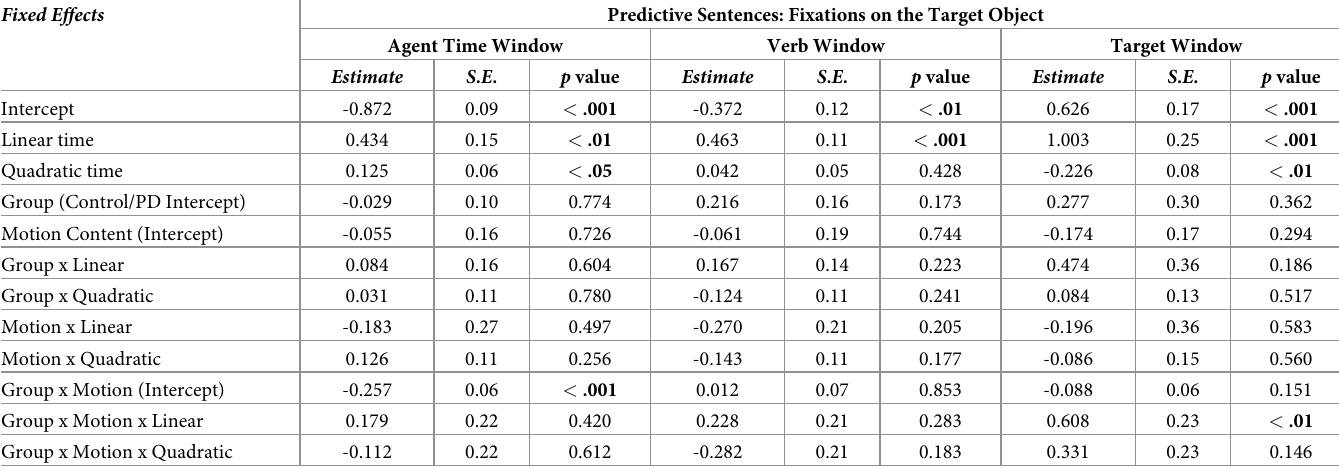
Table 3. Effect of motion content on gaze logits to the target entity during predictive sentences. Fixed